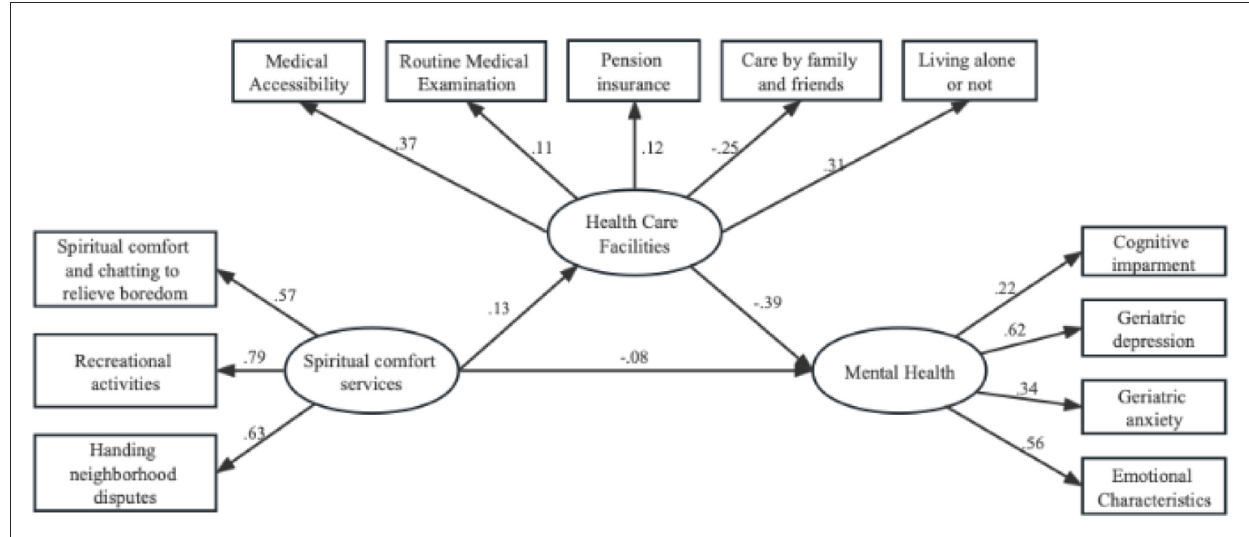
FIGURE3 Mechanisms of mental health impact pathways in older